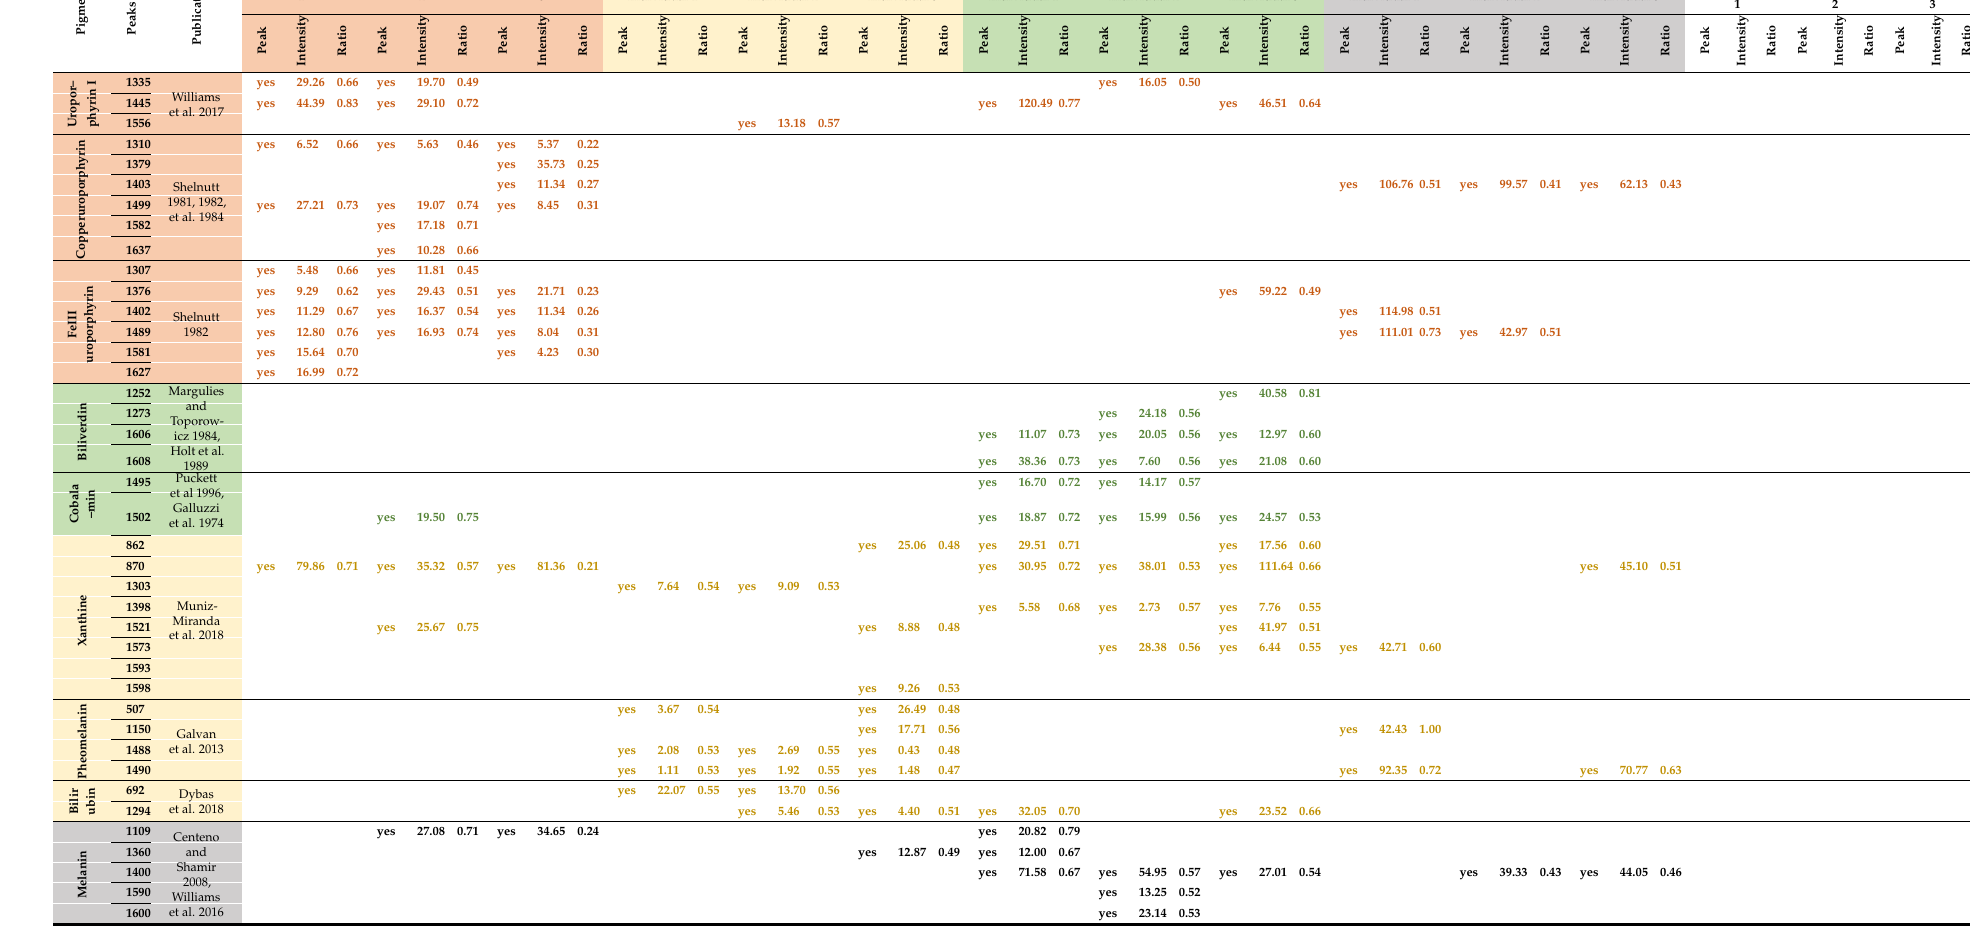
Table 2. Pigment validation by Raman spectroscopy, synthetic results. Raman signatures characteristic of each pigment found in the literature; Peak characterization (identify peaks matching or not expected signals), peak intensity (the value of the lowest point of the peak minus the value of the peak) and ratio relative to the intensity of the calcite reference peak (ratio was calculated between the intensity of the selected peak (calculated as previously described) and the peak of the referential calcite for each spectrum). Each red, yellow, green, black or white background/text color are corresponding to the phenotype color. The full table is presented in Supplementary Materials Table S9. n m e g P i